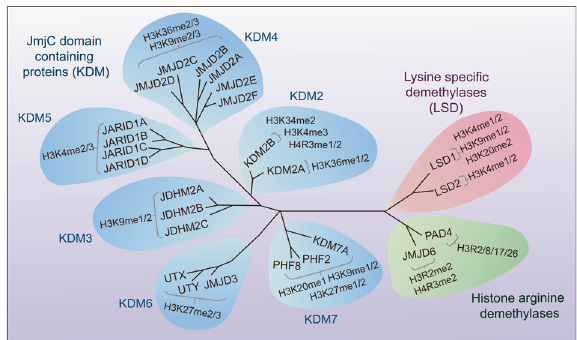
Fig. 5 Classi fi cation of histone demethylases and their demethyla- tion sites. There are three families of histone lysine demethylases (shown in different color): lysine-speci fi c demethylase (LSD) family, JMJD family consisting of six families with 21 jmjC domain- containing proteins, and histone arginine demethylases. And different demethylases can demethylate different methylation sites of histones